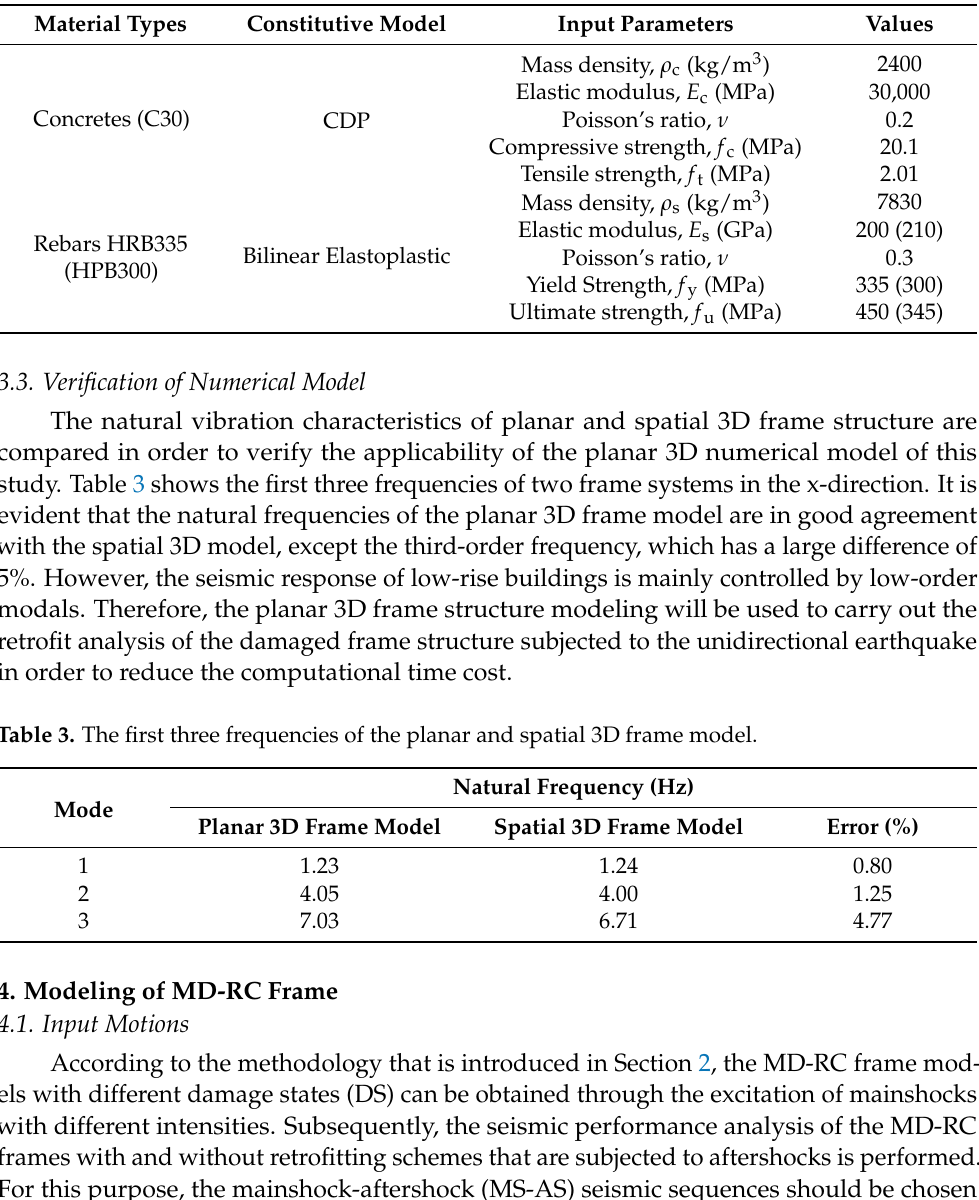
Table 2. Material input parameters of concretes and rebars in this study.